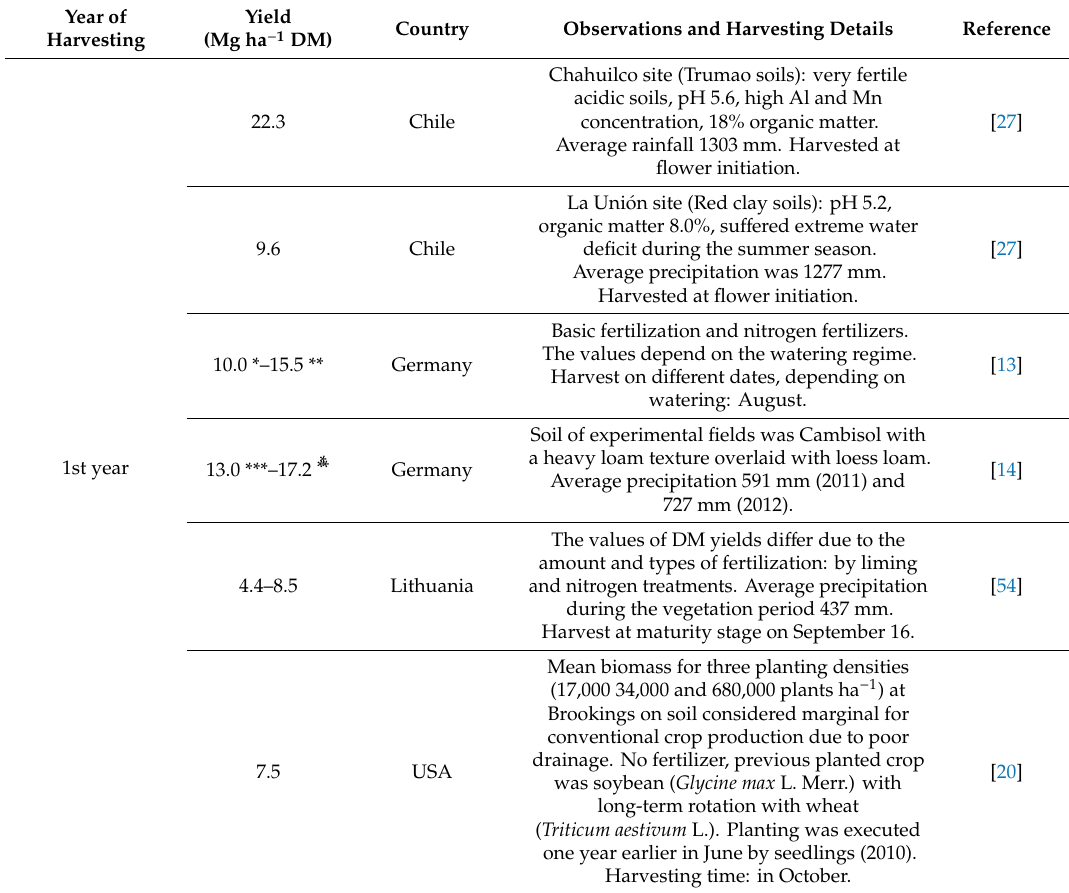
Table 1. Dry matter yield of Silphium perfoliatum in di ff erent years of